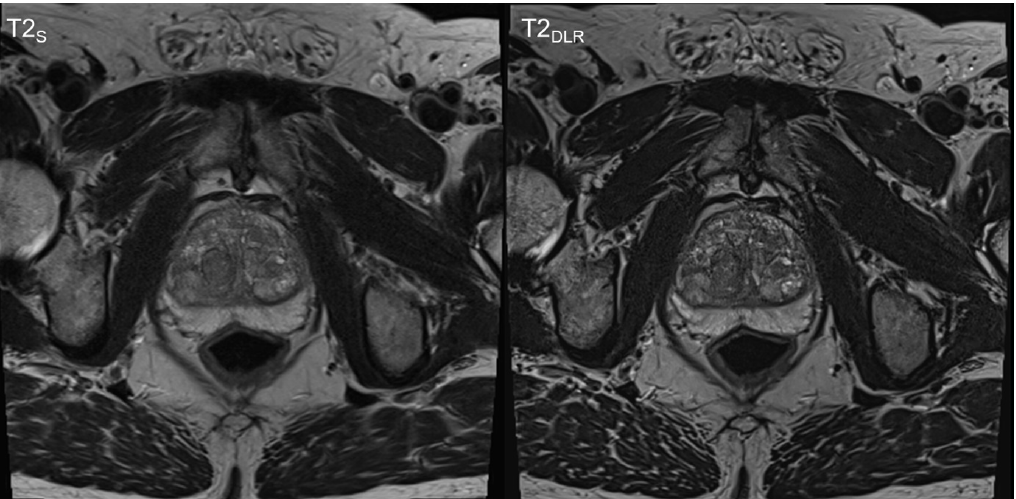
Figure 3. Sixty-nine-year-old man with suspicion of prostate cancer. Deep learning image recon- structed thin-slice imaging (T2 DLR ) is shown on the right-hand side and standard imaging (T2 S ) on the left-hand side. T2 DLR shows improved levels of sharpness and improved delineation of the prostate parenchyma. Biopsy revealed no malignancy.